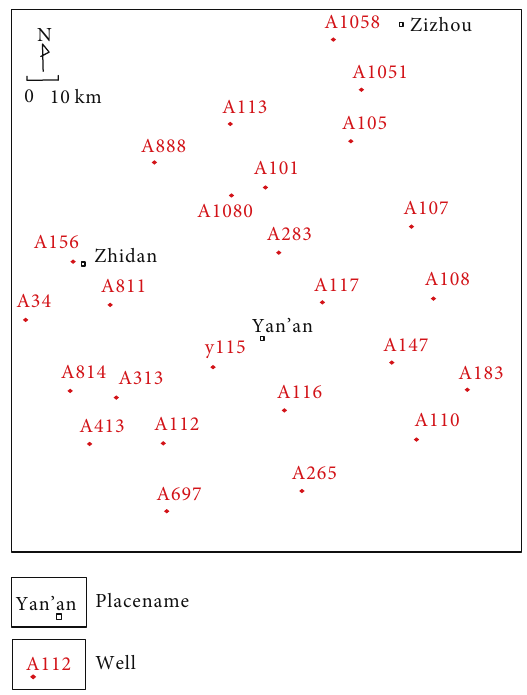
Figure 3: Location of the sampling